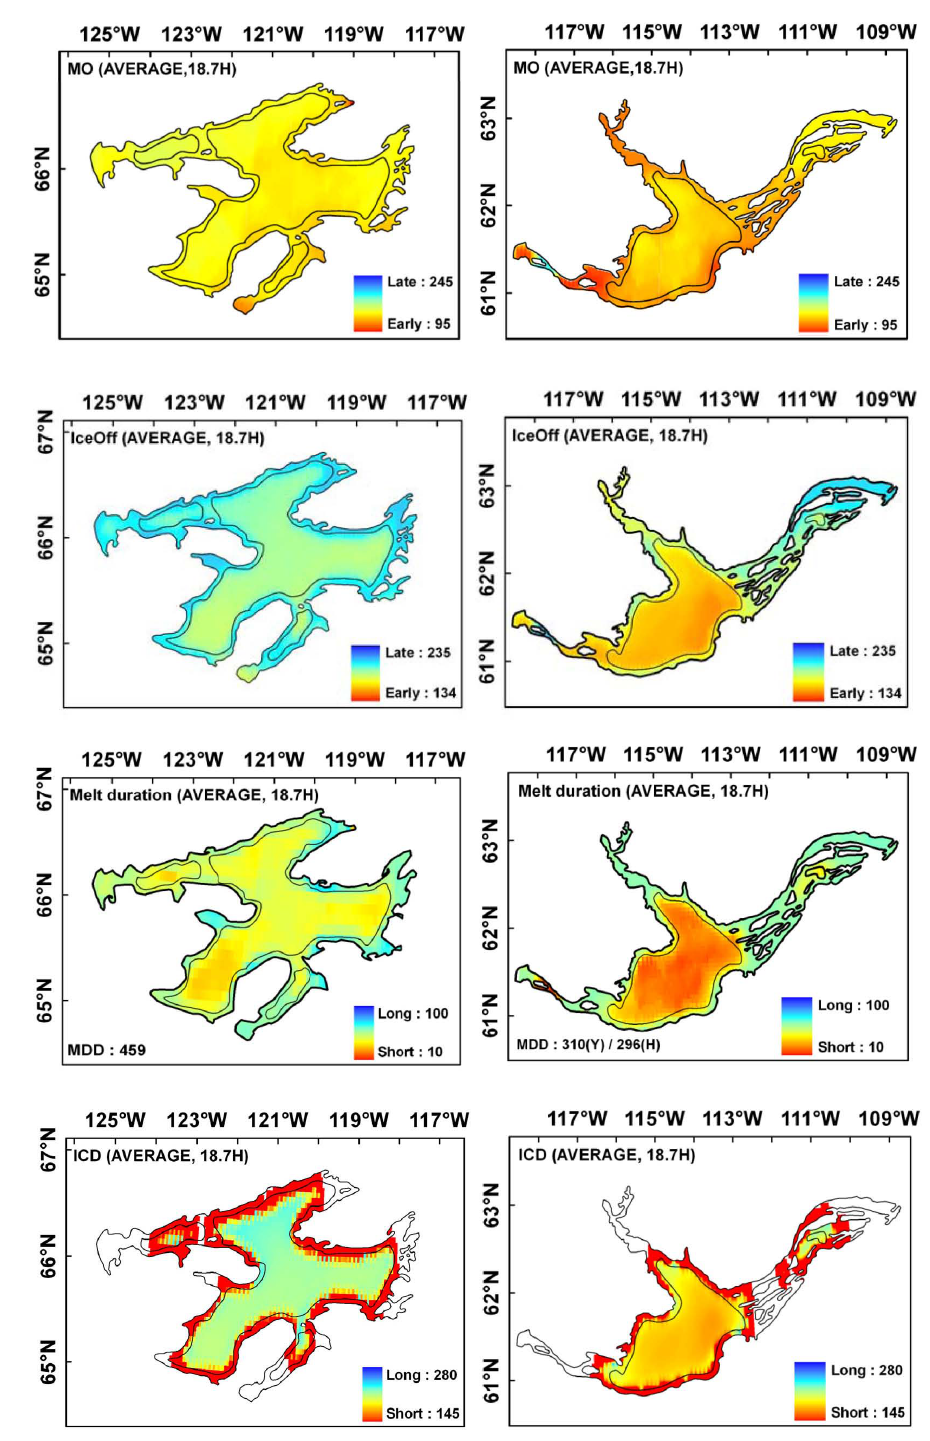
Fig. 5. Melt-onset (MO), ice-off, melt-duration, and ice-cover-duration (ICD) on average (2002–2009) for GBL (left panel) and GSL (right panel). Legend is day of